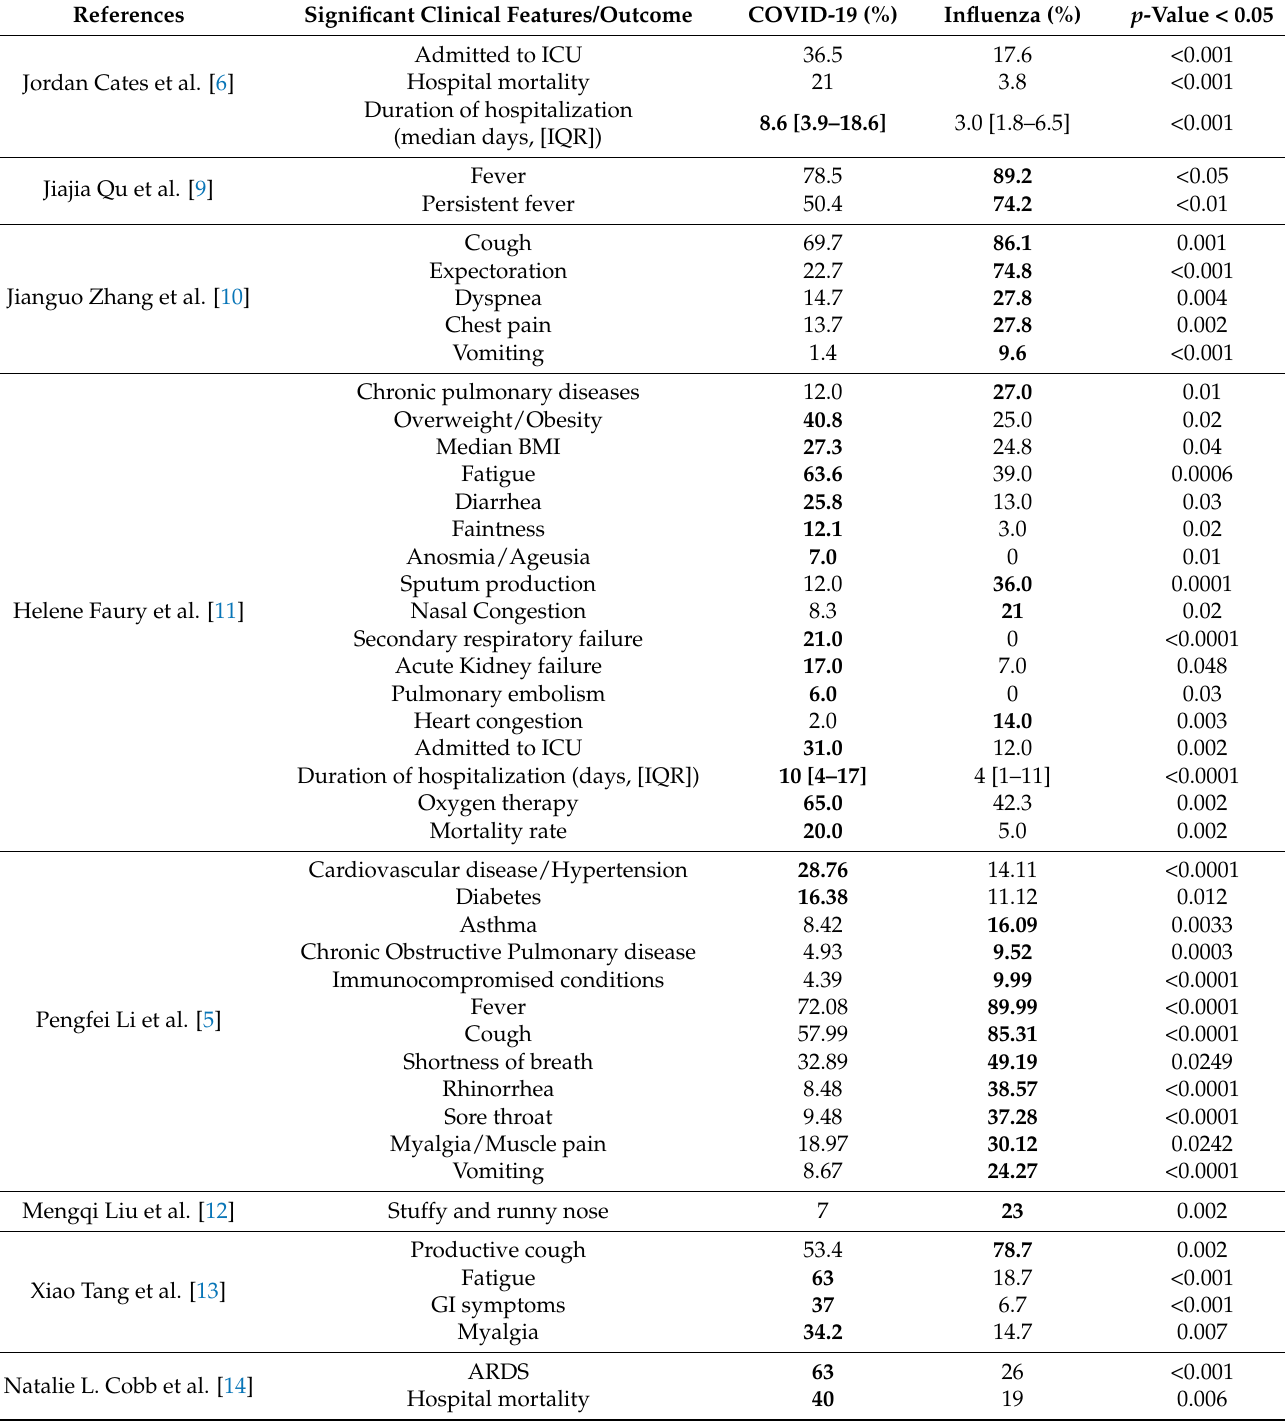
Table 2. Significant demographic and baseline characteristics, clinical features, and outcome in COVID-19 and influenza adult